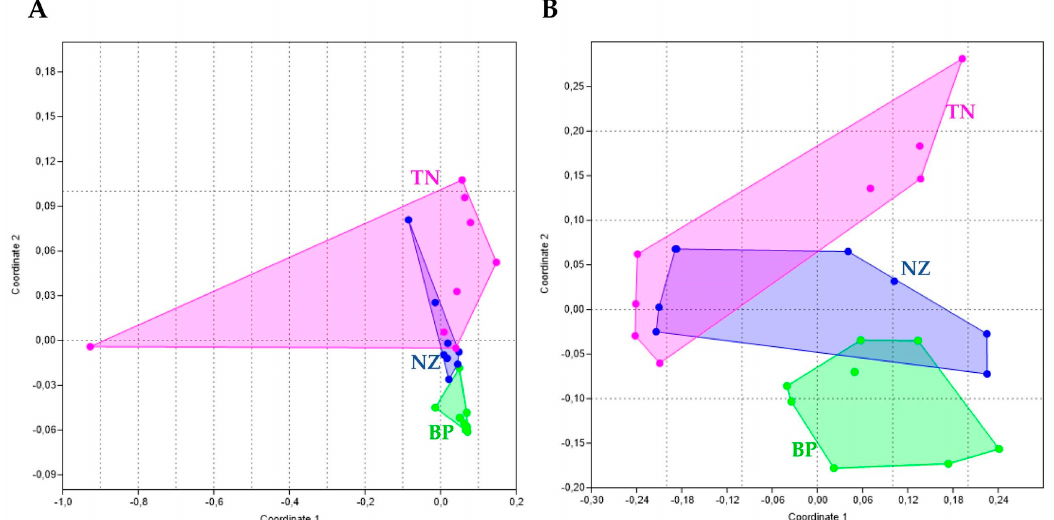
Figure 3. Nonmetric multidimensional scaling (NMDS) ordination plots, based on square-root transformed abundance data (PERMANOVA, p < 0.05). ( A ) Fungi, stress value = 0.11; ( B ) bacteria, stress value = 0.09.